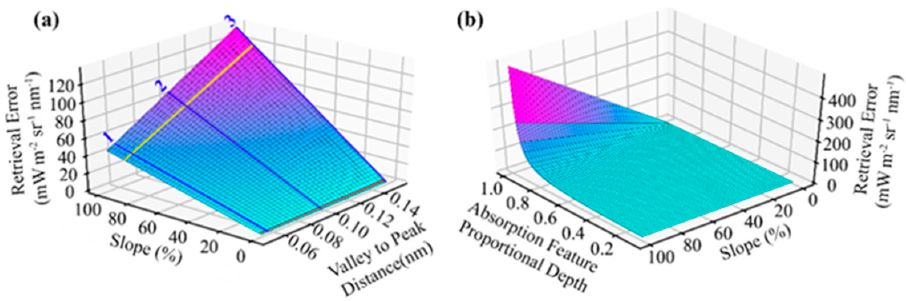
Figure 14. ( a ) Modelled relationship between error in an indirect SIF retrieval, the gradient of a sloped influence, and the spectral distance between a valley and a peak for an absorption feature of 0.9 proportional depth. For context, the approximate steepness of the leaf reflectivity (yellow line), and the SIF function (red line) at 730 nm, based on Figure A, are shown. Spectral distance equivalent to 1, 2, and 3 band intervals of FIREFLY (blue lines) are shown. ( b ) Modelled relationship between error in an indirect SIF retrieval, the gradient of a sloped influence, and the proportional depth of an absorption feature.